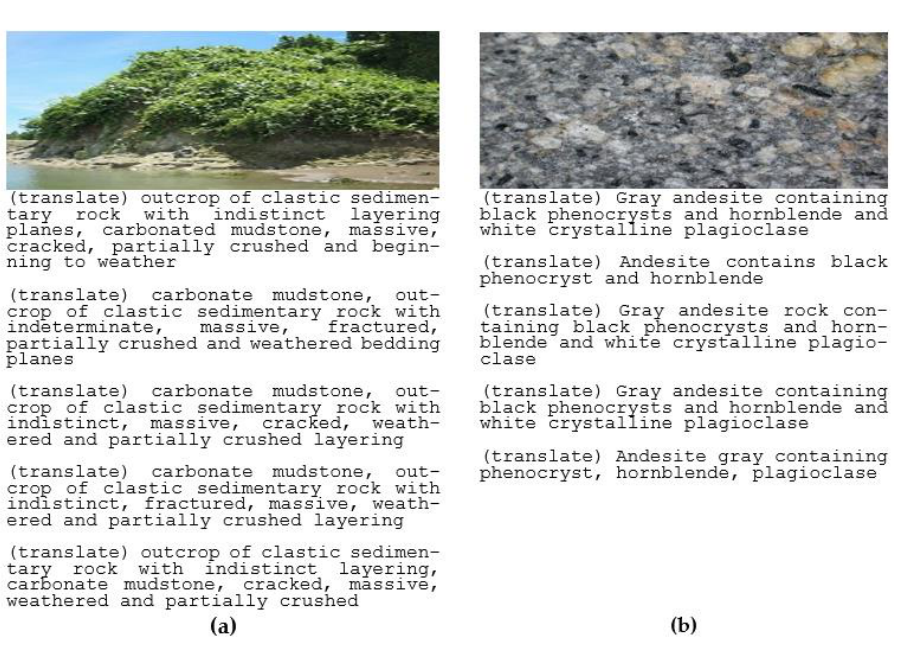
Figure 4. Geological rock images and their captions translated into English: ( a ) captions for the geological image of sedimentary rocks and translated into English; ( b ) captions for geological image on andesite contents and translated into English.